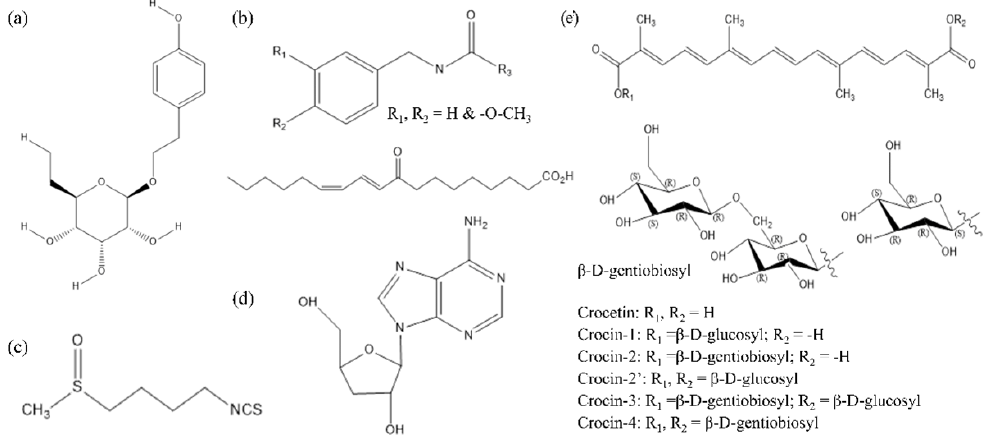
Figure 1. Structures of some special functional ingredients from high-altitude plants with anti-fatigue effect. ( a ) Salidroside from Rhodiola rosea L., ( b ) macaenes and macamides from Lepidium meyenii W., ( c ) sulforaphane from cruciferous family ( Brassica rapa L.), ( d ) cordycepin from Cordyceps sinensis Sacc. , ( e ) crocin from Crocus sativus L.